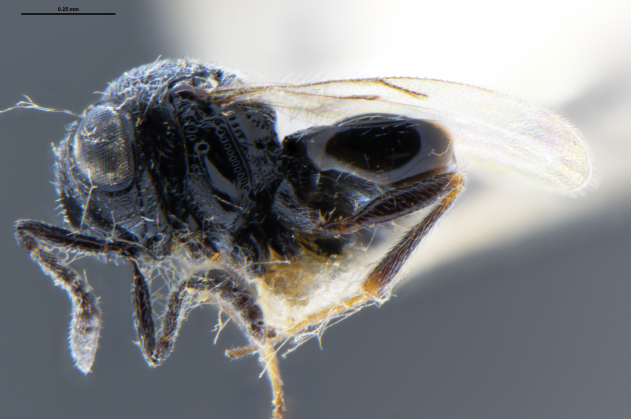
lateral habitus